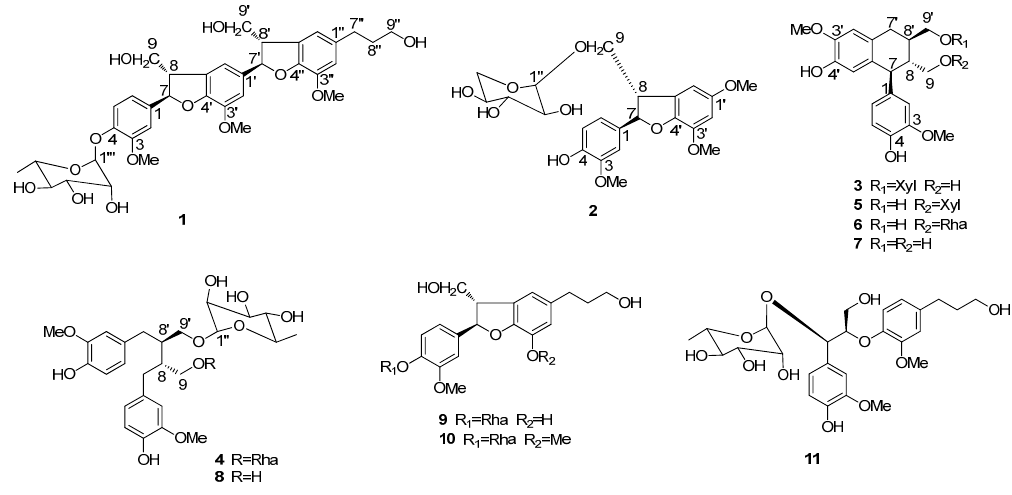
Figure 1. Chemical structures of 1–11.